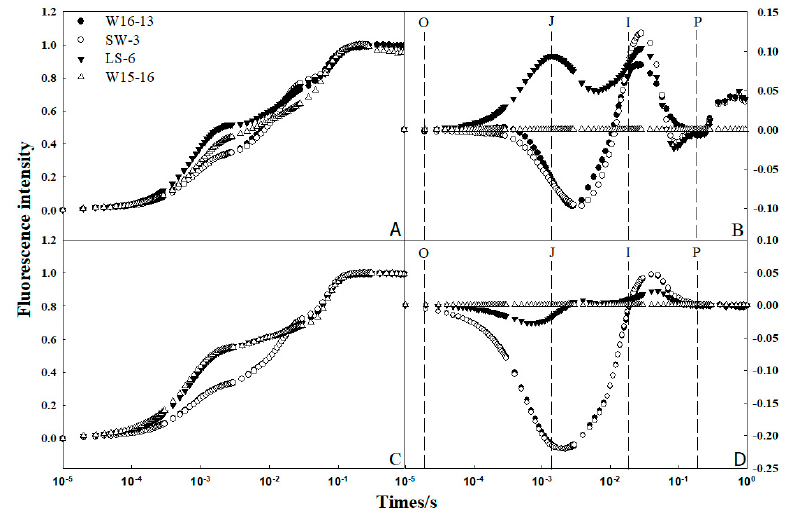
Figure 10. Effect of low temperature on the fluorescence transient of four genotypes of wucai. OJIP transients were measured after 25/18 °C (d/n) ( A , B ) and 8/2 °C (d/n) ( C , D ) of exposure to low